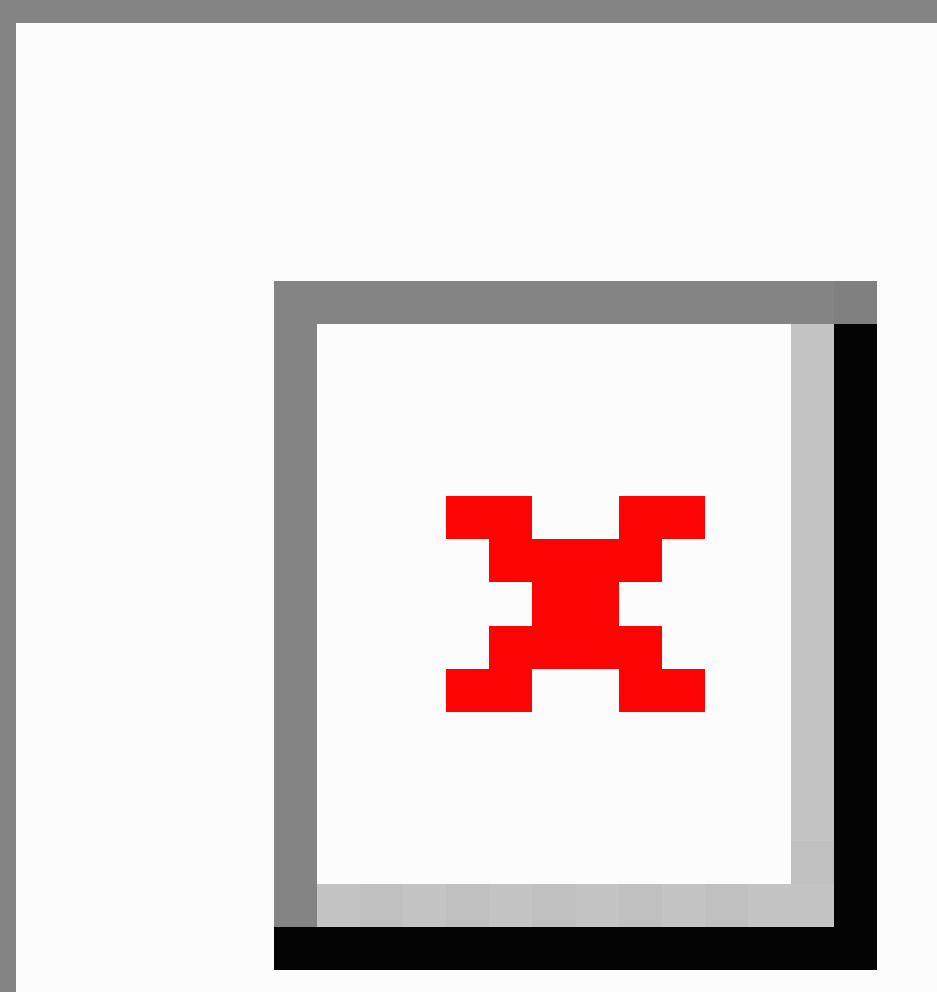
Figure 3. Antenna sites: 1050 Riverside Dr, New York, NY 10032. [Magnification